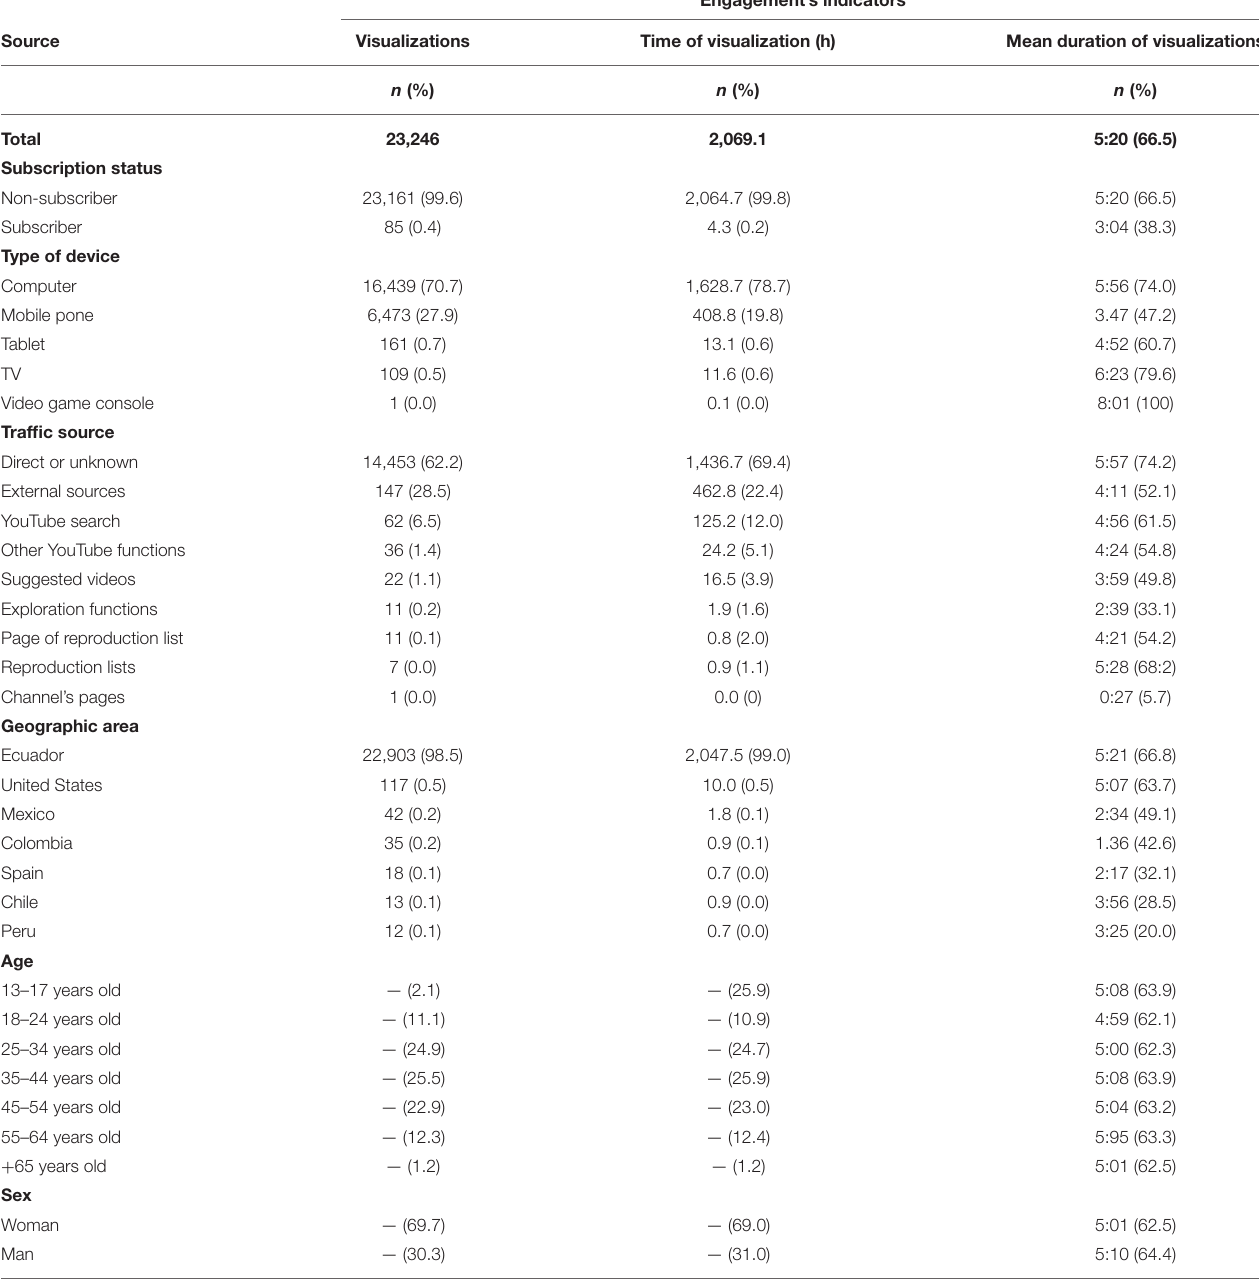
TABLE 4 | Analytics of the viral video’s engagement